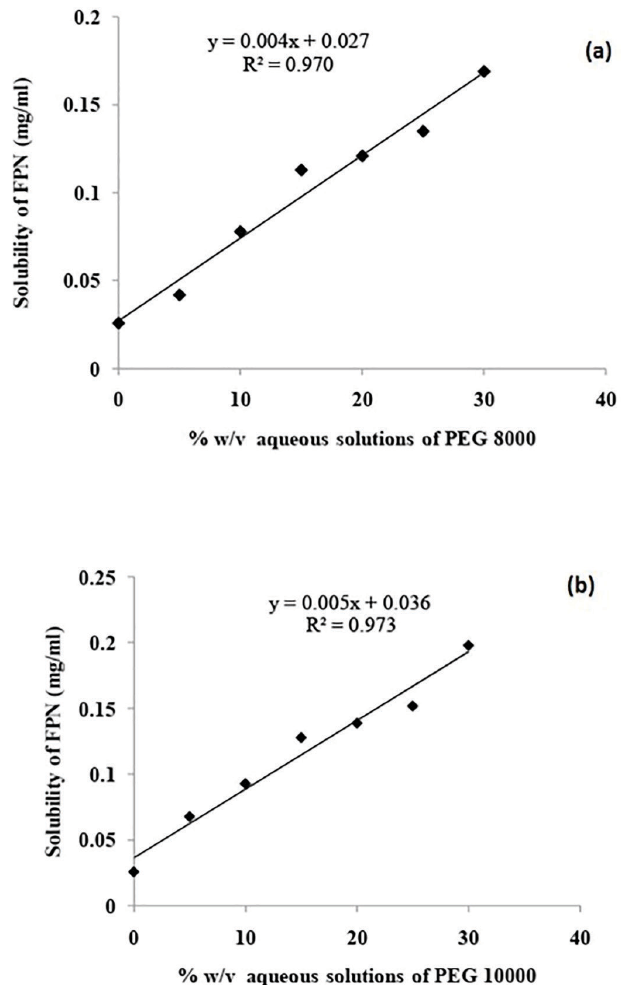
FIGURE 1 - Phase solubility curves of FPN in aqueous solution